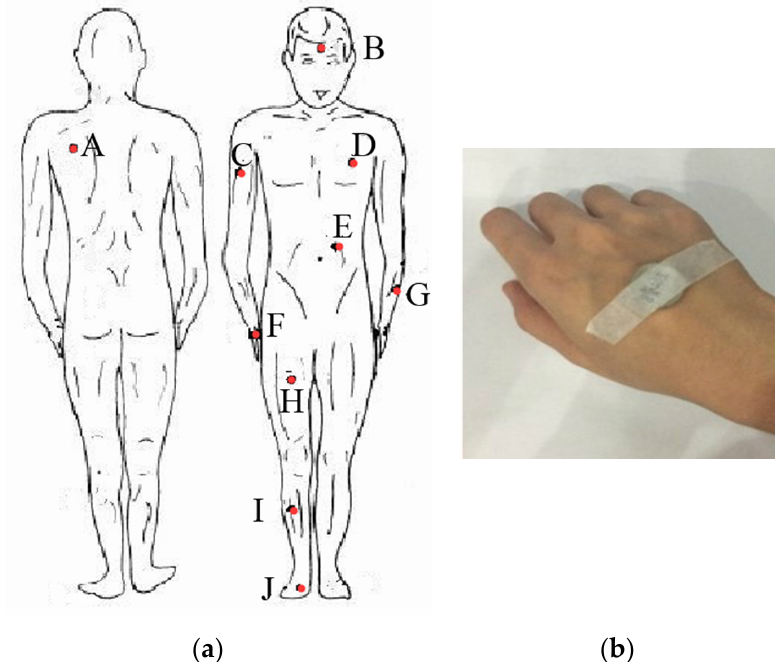
Figure 2. Skin temperature measurement . ( a ) Measured local body parts. (A: left back, B: forehead, C: right upper arm, D: left chest, E: belly, F: right hand back, G: left forearm, H: right thigh, I: right calf, J: right foot back); ( b ) IButton placement. Table 3. The weighting factors of the ten body parts for mean skin temperature calculation. Forehead Chest Belly Back Upper Arm Forearm Hand Back Thigh Calf Foot Back